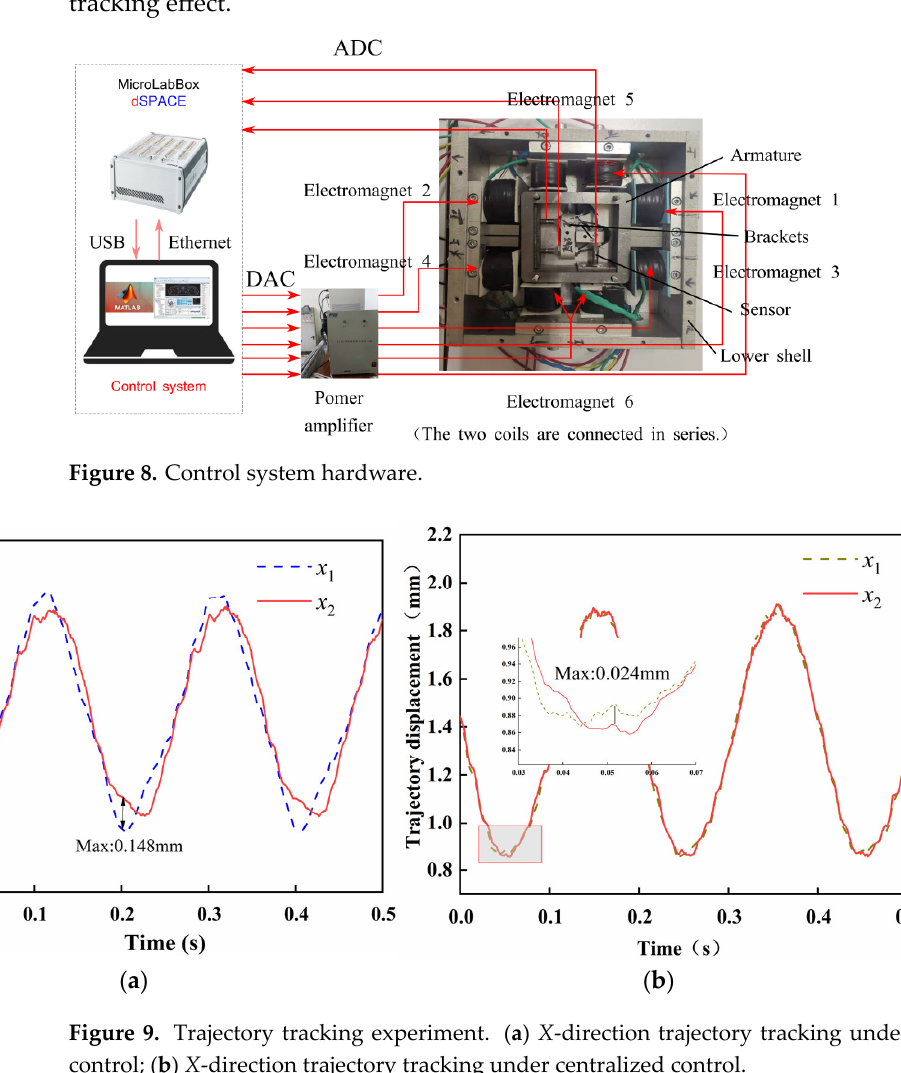
Figure 9. Trajectory tracking experiment. ( a ) X ‐ direction trajectory tracking under decentralized control; ( b ) X ‐ direction trajectory tracking under centralized control. control; ( b ) X ‑direction trajectory tracking under centralized